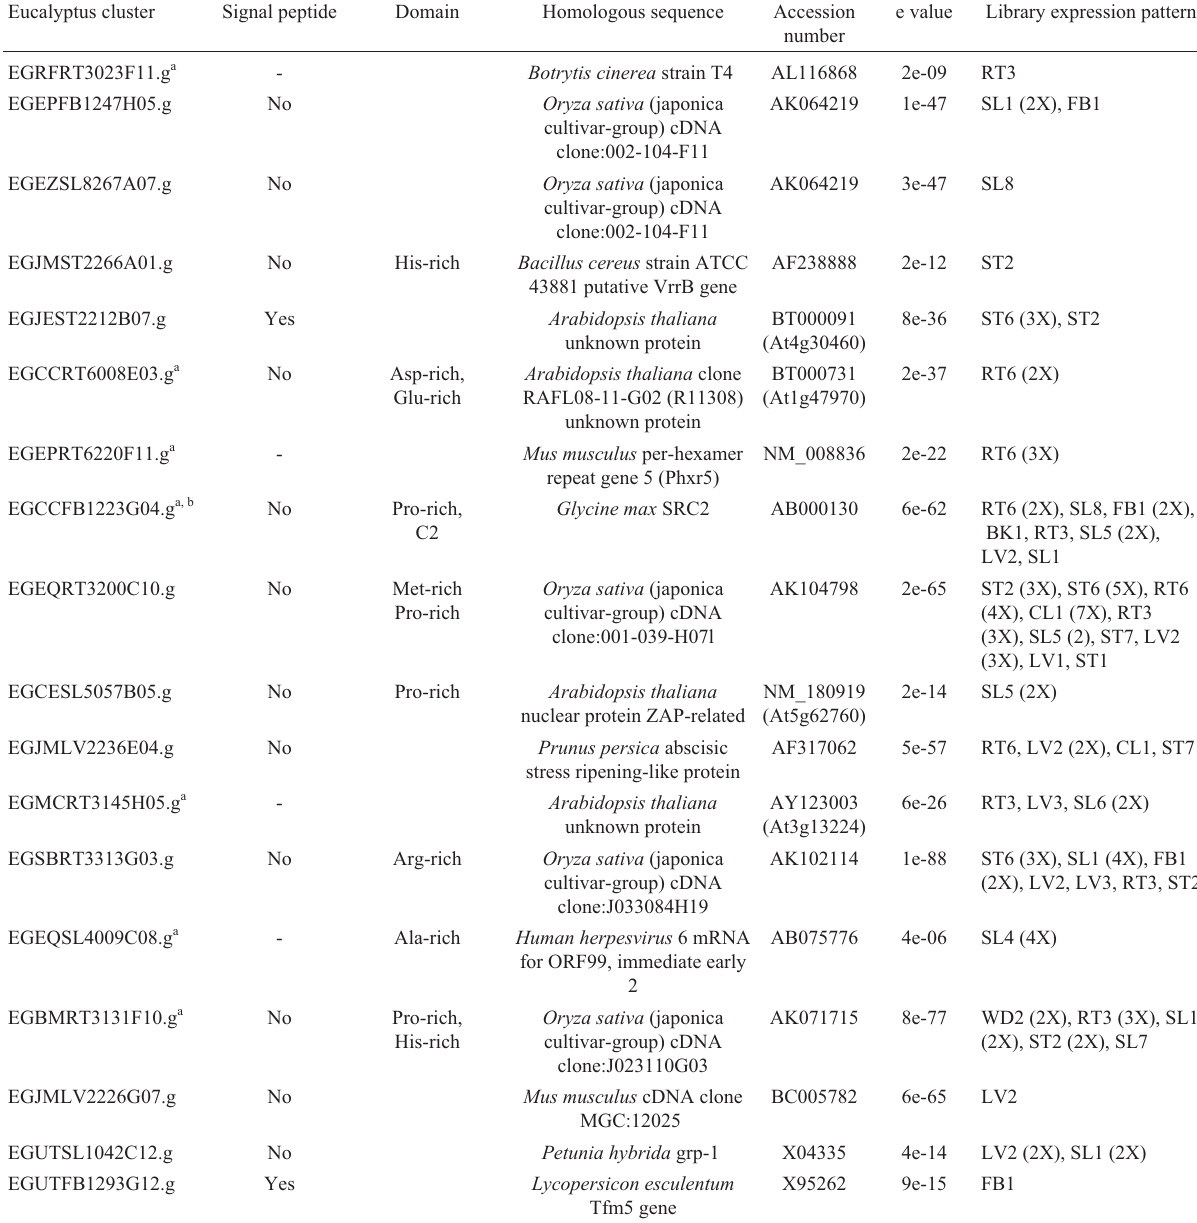
Table 5 - Eucalyptus ESTs encoding GRPs with lower glycine content (GXGX).